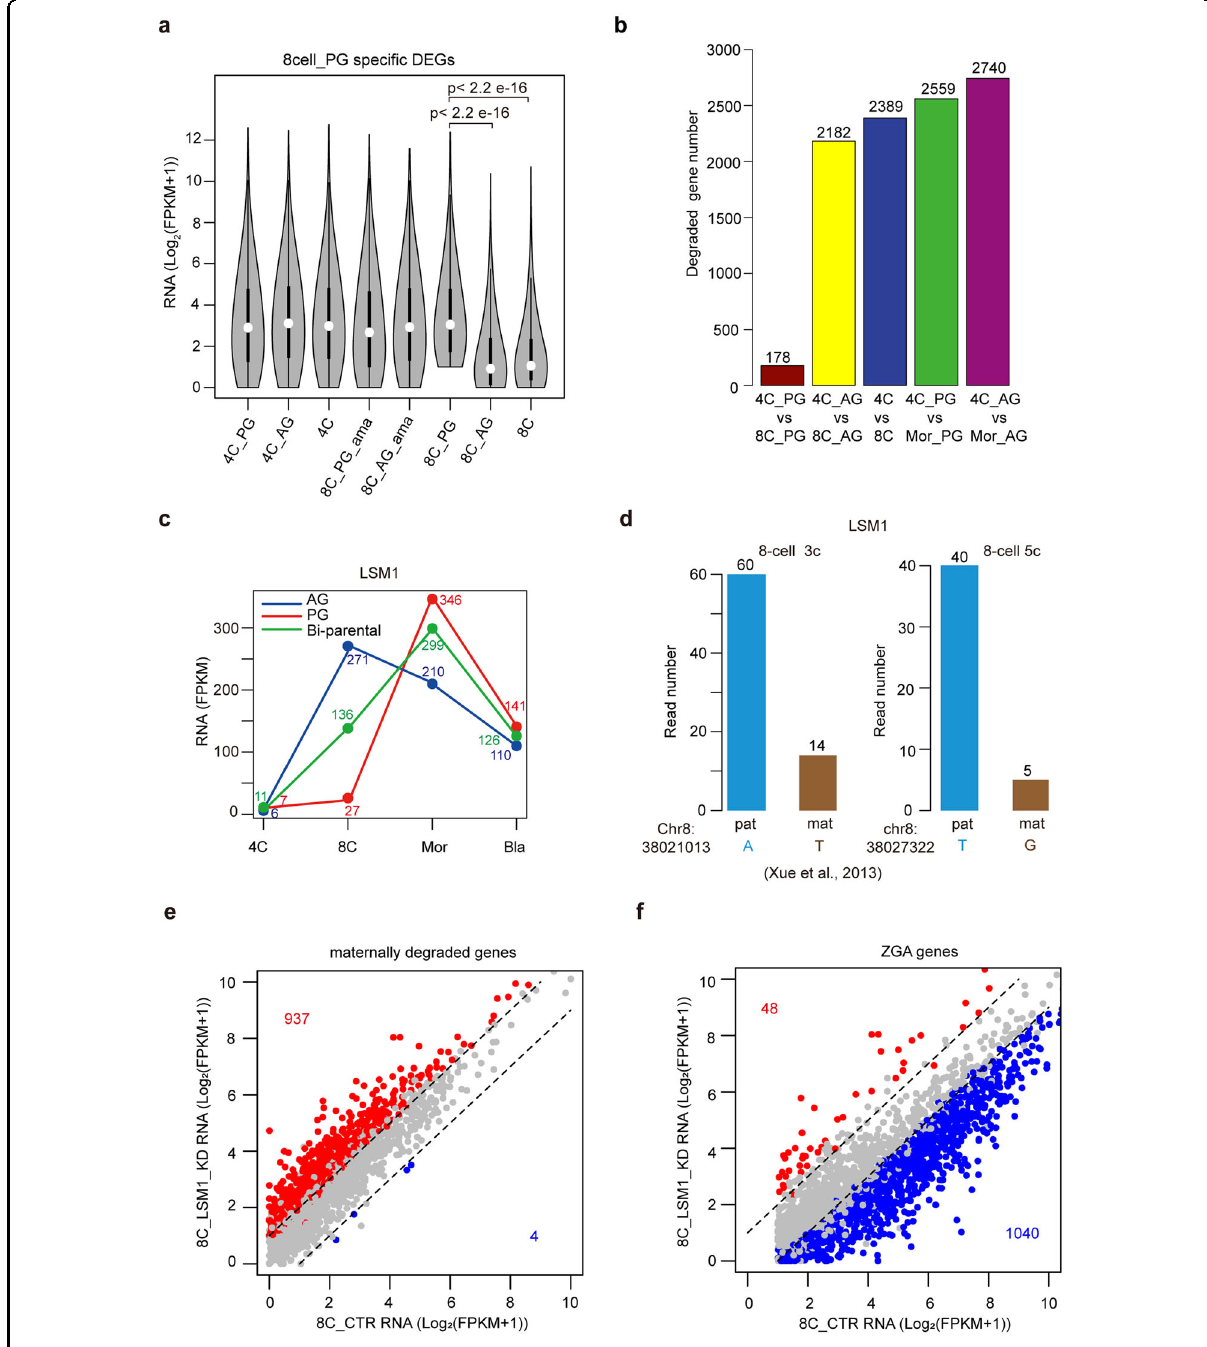
Fig. 3 Paternally activated MRD is essential for ZGA in human. a Violin plots showing the expression levels of PG speci fi cally expressed genes at the 8-cell stage in the indicated human embryos. Wilcoxon rank sum test was used. b Bar plot showing the numbers of maternal genes whose transcripts are degraded in haploid or bi-parental embryos from 4-cell to 8-cell or morula stages. c Plot showing the expression levels of LSM1 in human haploid and bi-parental embryos. d Bar plot showing the read numbers for LSM1 transcripts from paternal and maternal genomes in human bi-parental 8-cell embryos (samples 3c and 5c). The RNA-seq data are from 35 . The locations of SNPs, and the alleles at these SNP loci in maternal and paternal genomes are indicated. e Scatter plot showing the expression levels of maternally degraded genes between LSM1 KD and control 8-cell embryos. The genes upregulated in LSM1 KD embryos are labeled in red, while the genes downregulated in LSM1 KD embryos are labeled in blue. The numbers of maternally degraded genes belonging to DEGs are indicated. f Scatter plot showing the expression levels of ZGA genes between LSM1 KD and control 8-cell embryos. The genes upregulated in LSM1 KD embryos are labeled in red, while the genes downregulated in LSM1 KD embryos are labeled in blue. The numbers of ZGA genes belonging to DEGs are